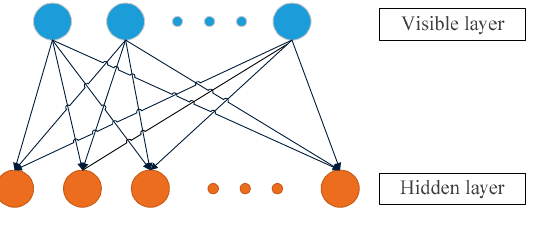
Figure 4. Schematic diagram of DBN.